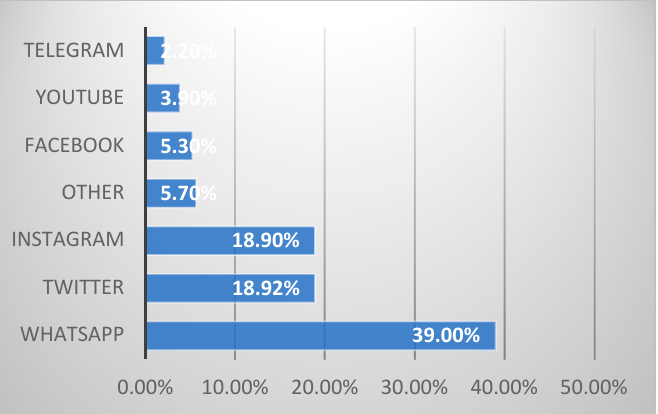
Figure 1. Graph of social networks used to share podcasts/Source: Prepared by the author.